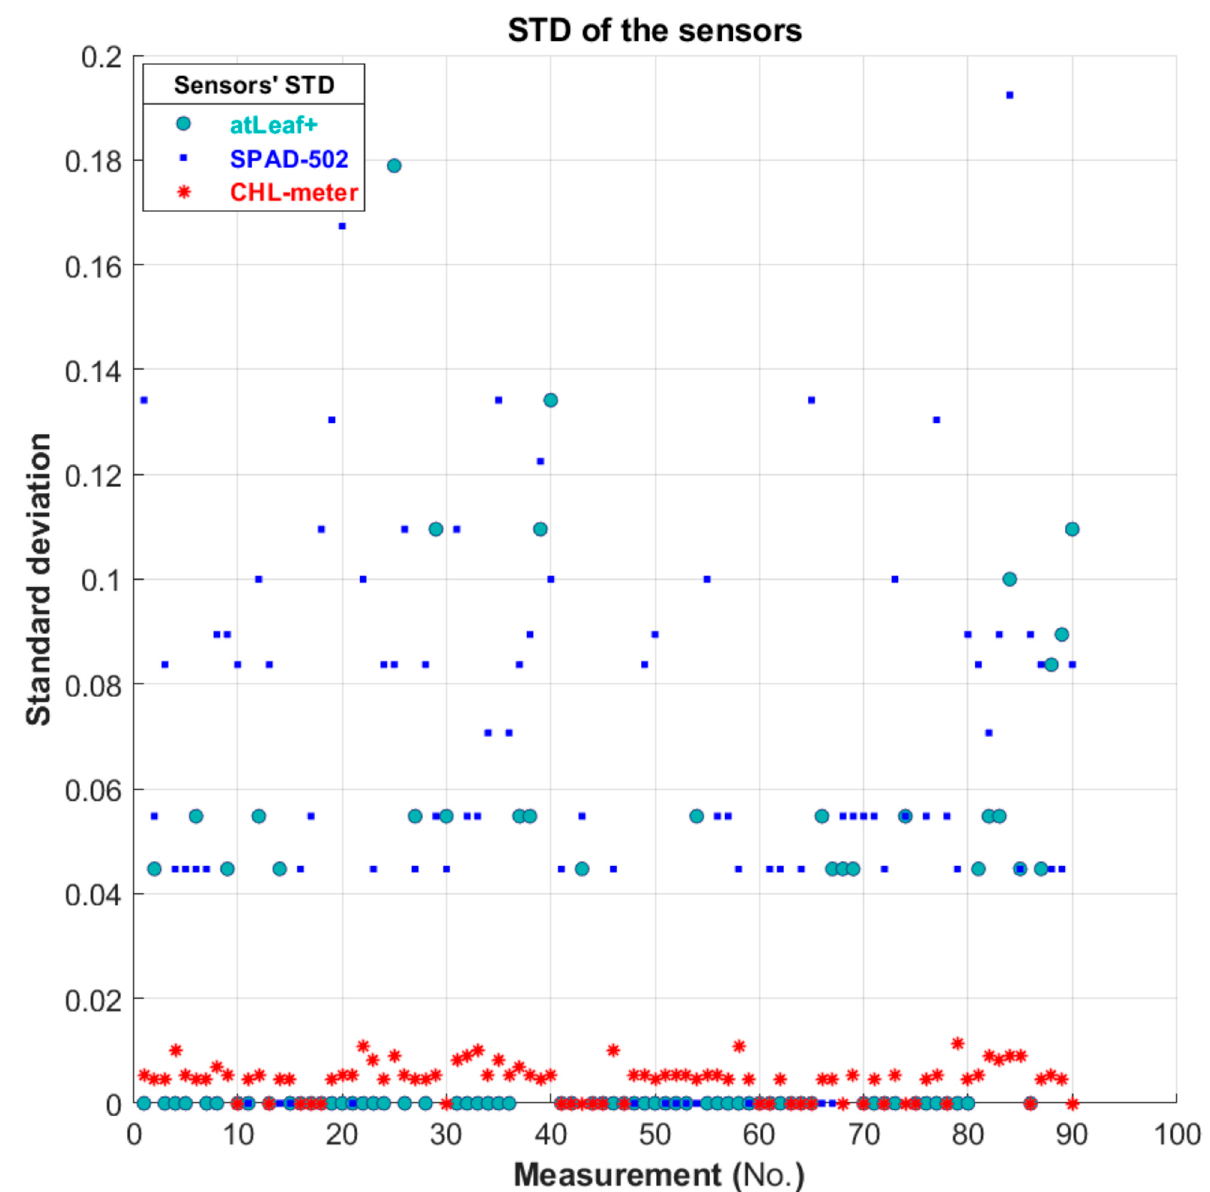
Figure 11. Plot showing the standard deviation among each of the measurements performed, with the 3 sensors used, on the 9 green filters only (90 points in total, 10 random areas per filter, 5 measurements per point).